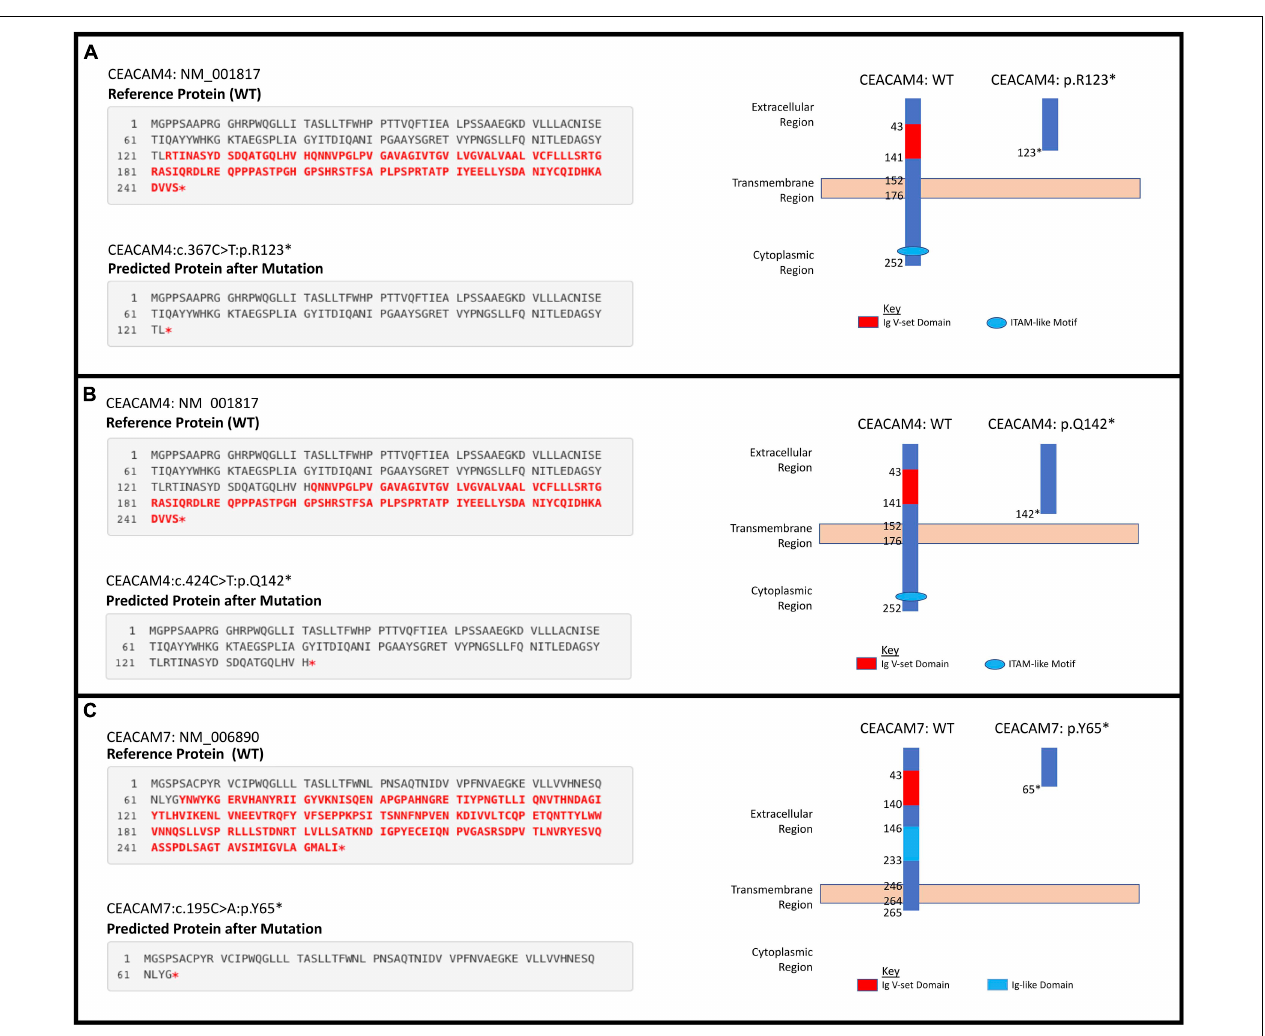
FIGURE 3 | Individual significant stop gain mutations. (A) CEACAM4 c.367C > T;p.(Arg123 ∗ ). (B) CEACAM4 c.424C > T;p.(Gln142 ∗ ). (C) CEACAM7 c.195C > A;p.(Tyr65 ∗